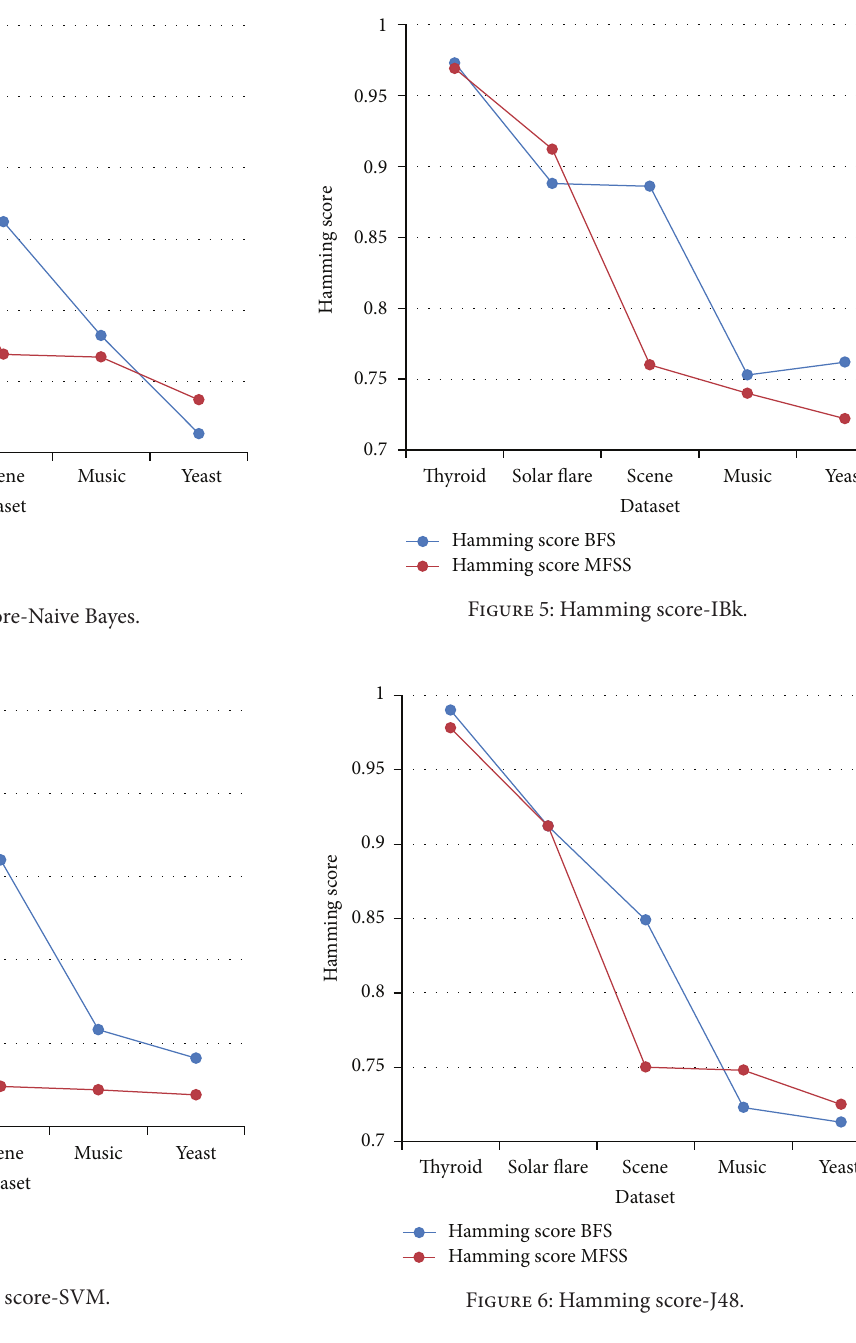
Figure 4: Hamming score-SVM.